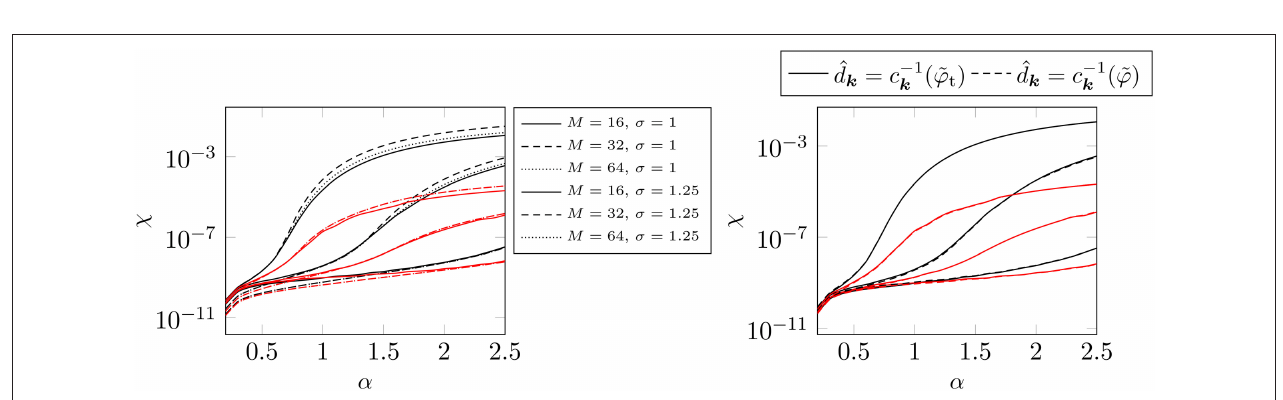
3 , M 32 , where σ 1 (black) and σ 1.25 (red). On the right hand side we plot the = = = = b opt (solid) and with b b 0 (dashed), respectively. (Window function: Gaussian). = =